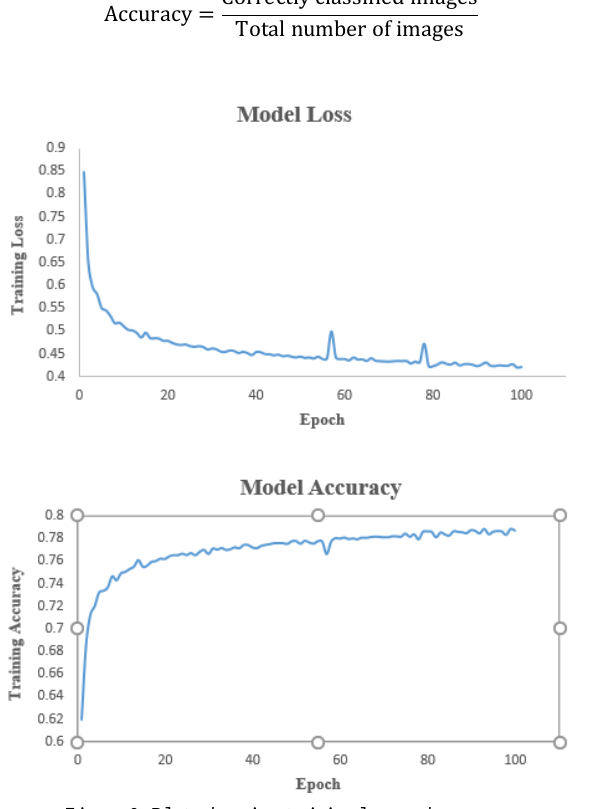
Figure 9. Plots showing training loss and accuracy